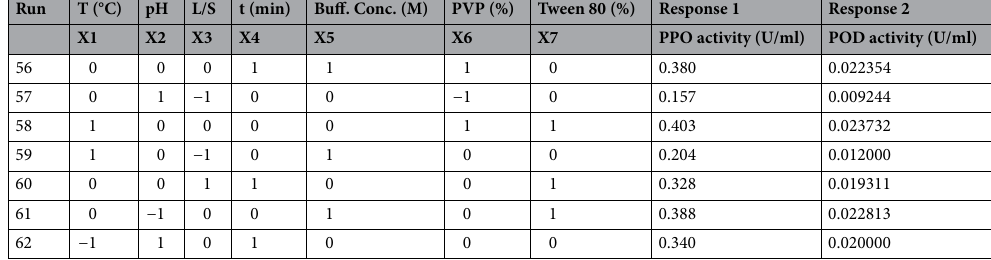
Table 1. The detailed specifications of the experiments and PPO/POD activity design based on the Box- Behnken method. Bold values indicate the maximum value.